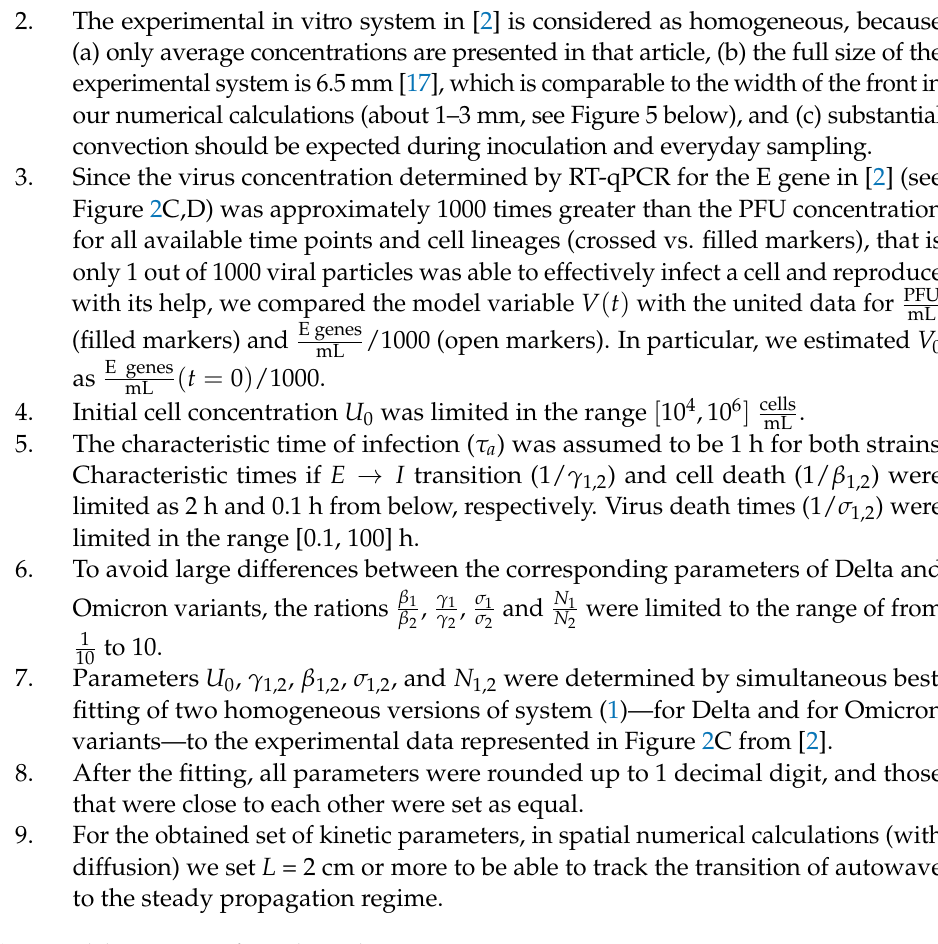
Table 1. Model parameters for Delta and Omicron